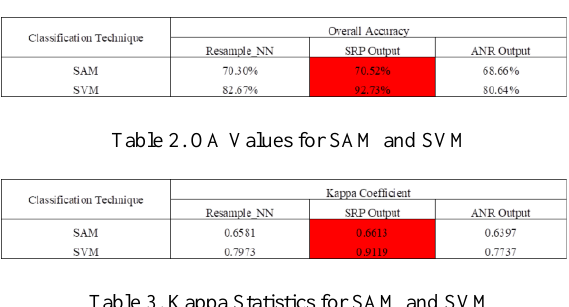
Table 3. Kappa Statistics for SAM and